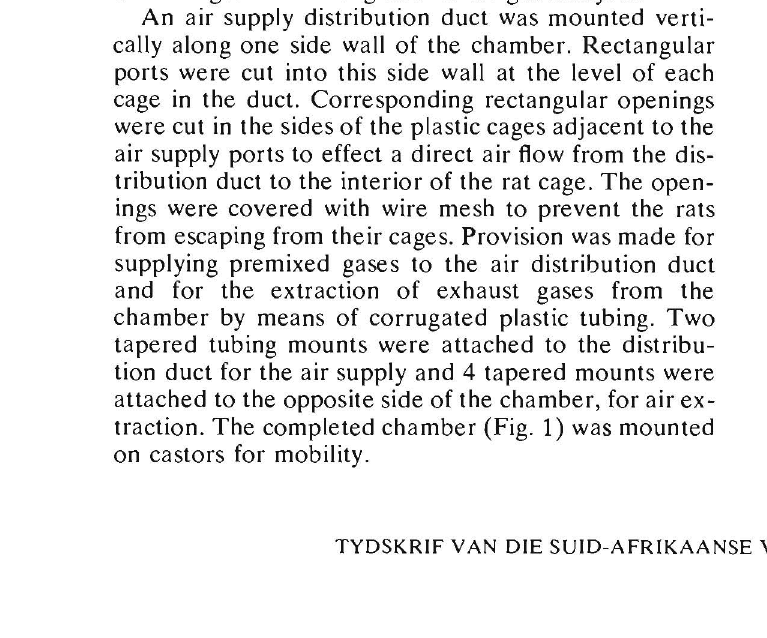
Fig. 3 Inhalation chambers with central gas metering and mixing